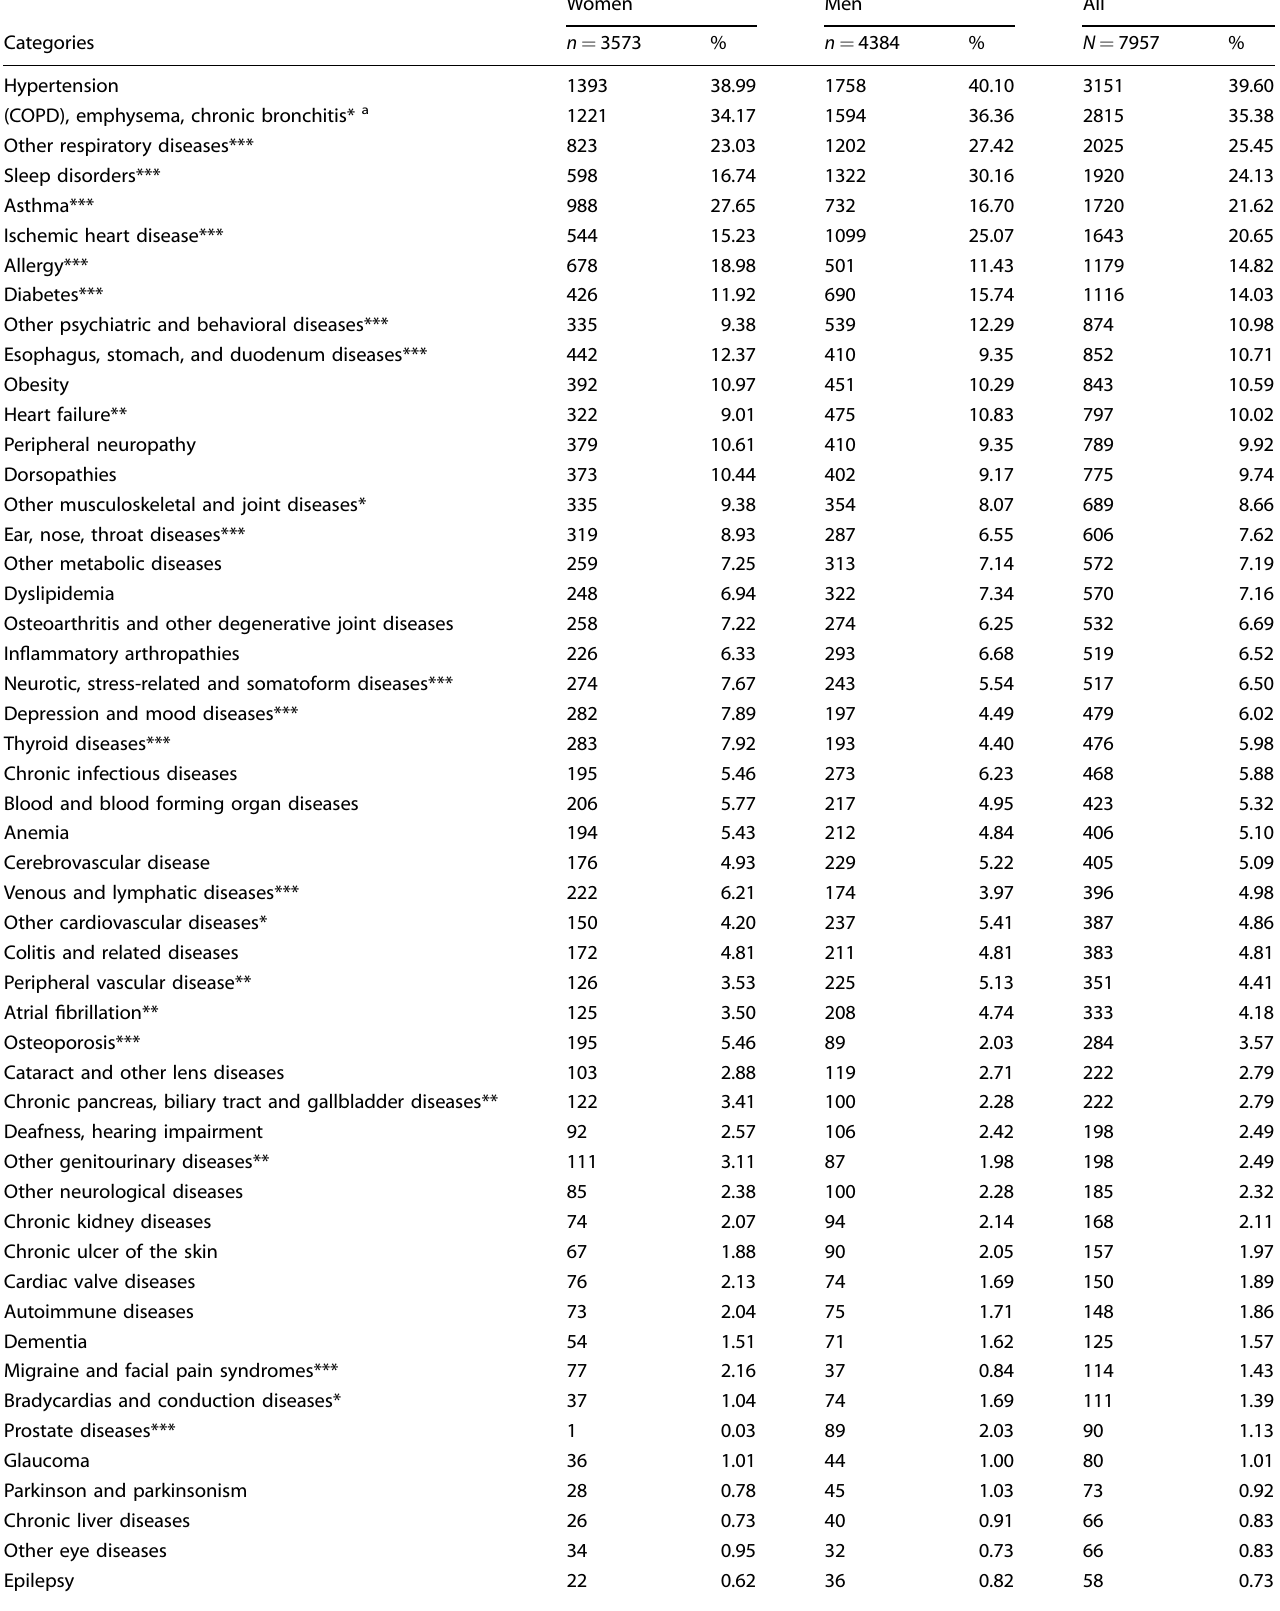
Table 2. Frequency of chronic comorbid conditions (CCC) by gender. Women Men